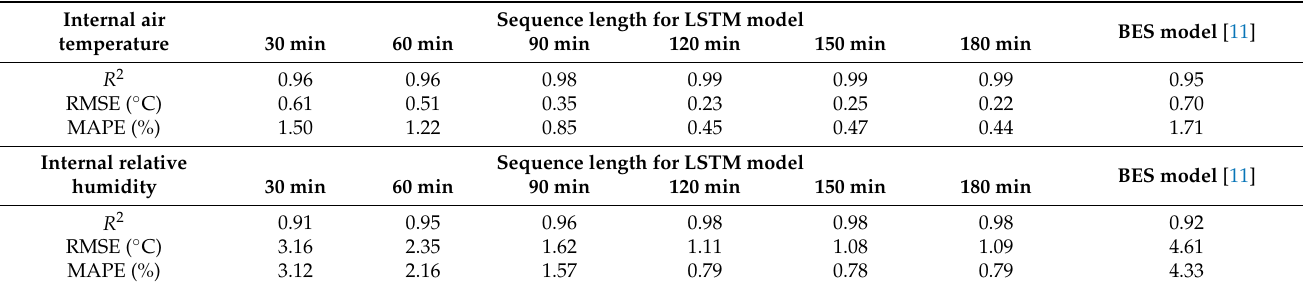
Table 5. Validation of RNN model according to sequence lengths (mechanically ventilated duck house,